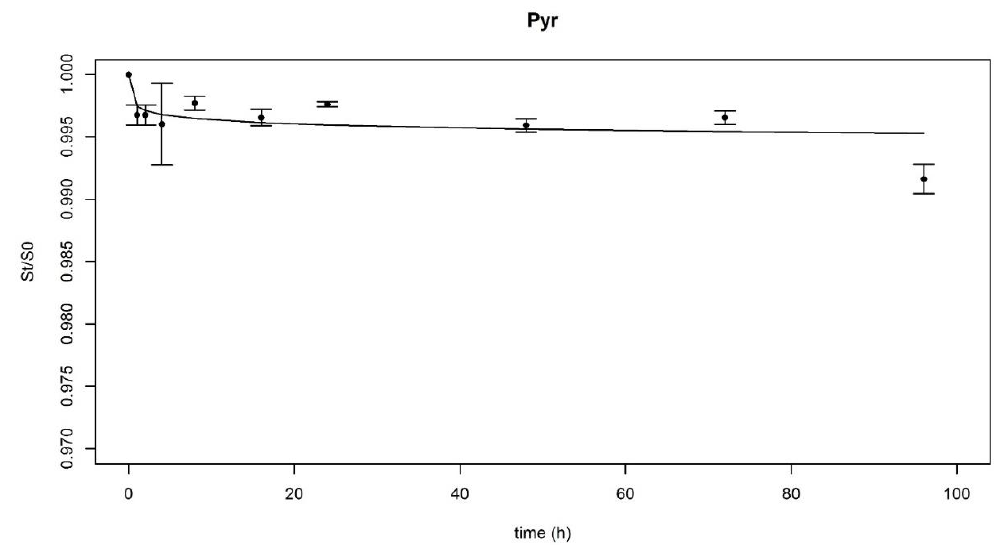
Figure 1. Example of desorption kinetic obtained using Tenax ® beads (the data and the modelling are for pyrene). St / S0 is the remaining sorbed fraction according to extraction time. The dots are the data means ± confidence interval ( α = 5%, n = 4 or 5); the line is the fitted site distribution model.